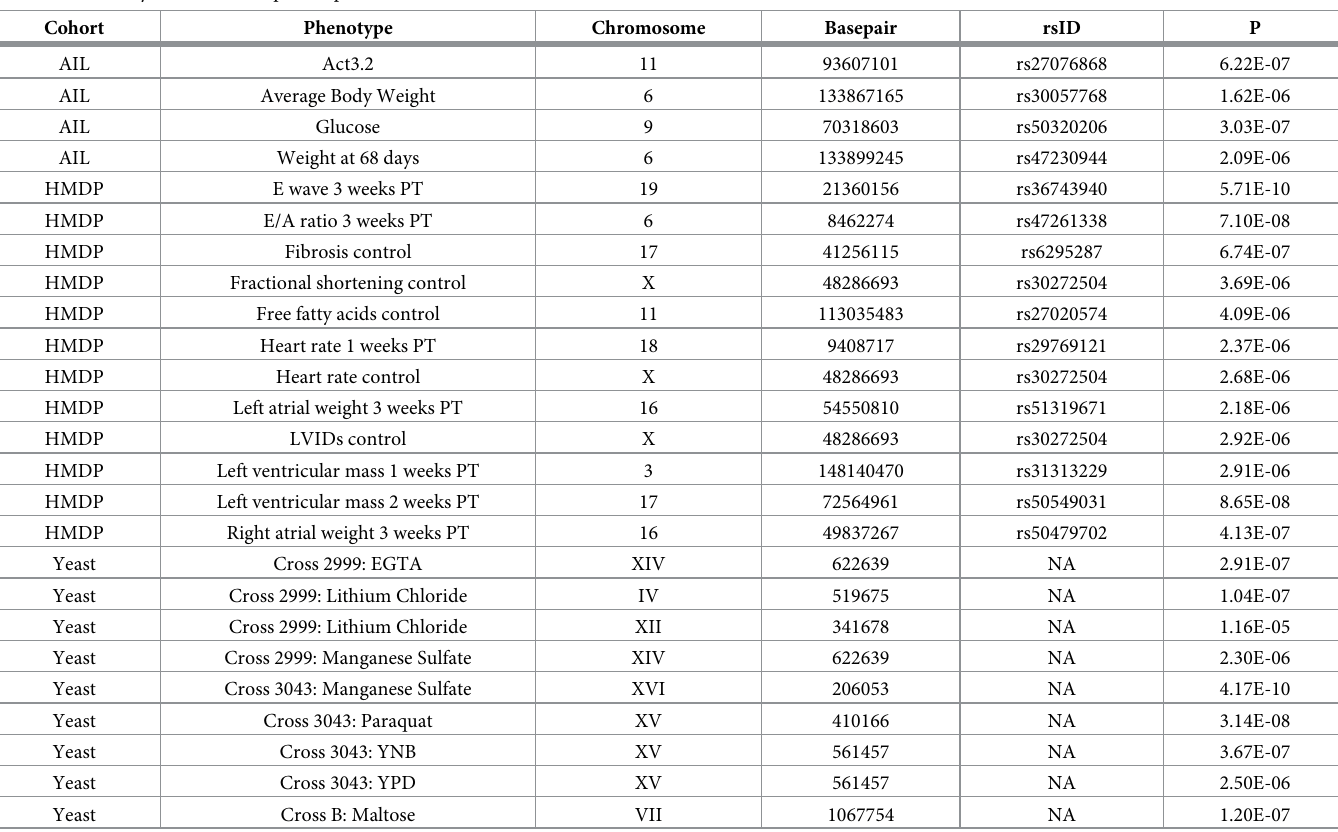
Table 1. Most significant Gx θ associations for each phenotype observed in the AIL or HMDP cohorts as well as all Yeast Gx θ loci passing a cross-wide 5% FDR threshold See S1 Table for complete list of loci. Act3.2 is ‘activity levels in control animal on day 3 of a conditioned place preference test’, LVIDs is ‘left ventricular inter- nal dimension at systole’ and PT is post isoproterenol